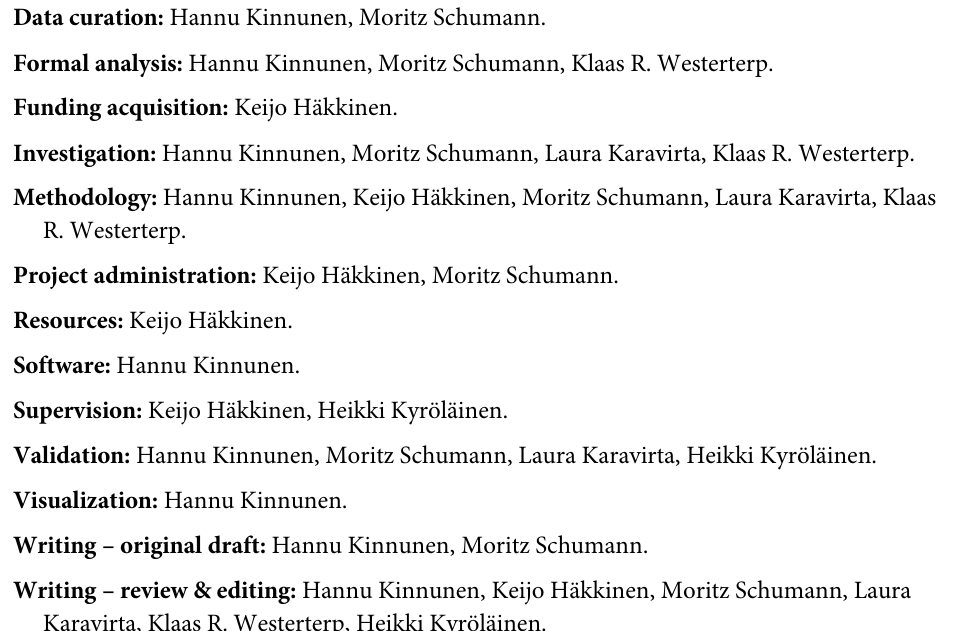
S1 Table. Individual daily energy expenditure from Wearables. Data are averaged separately for control days, non-exercise days and exercise days. S2 Table. Reported daily intake on exercise and non-exercise days. Data from control period, and separately on non-exercise and exercise days from training